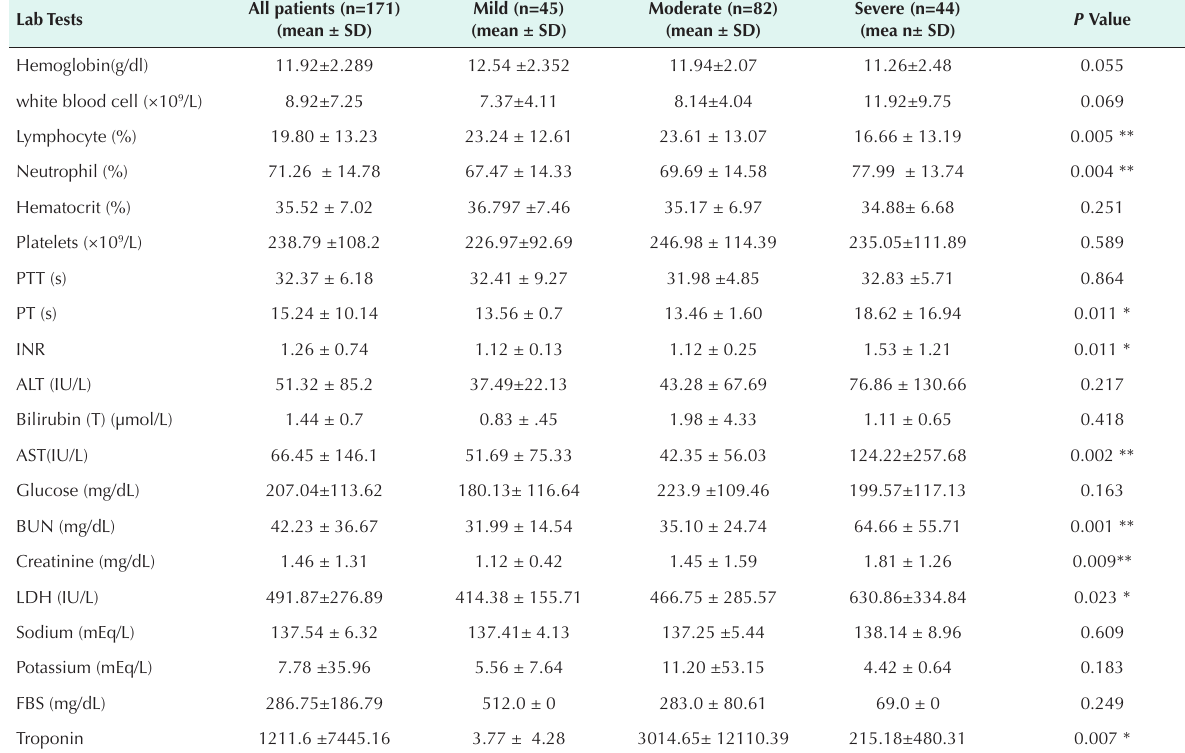
Table 3. The Association Between Different Groups of Severity with Laboratory Tests Lab Tests